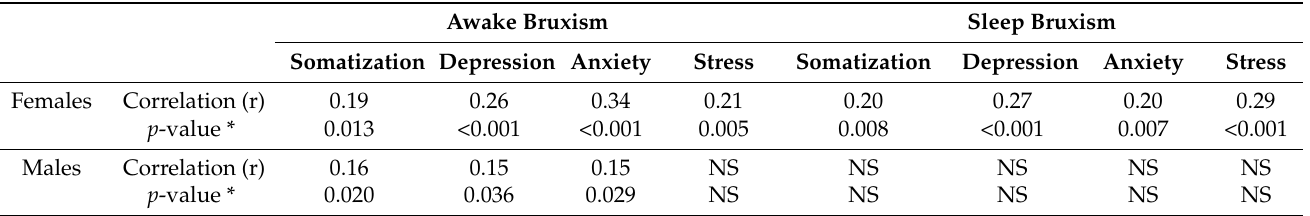
Table 2. The association between the emotional parameters and the report of AB/SB in males and females (Spearman correlation).